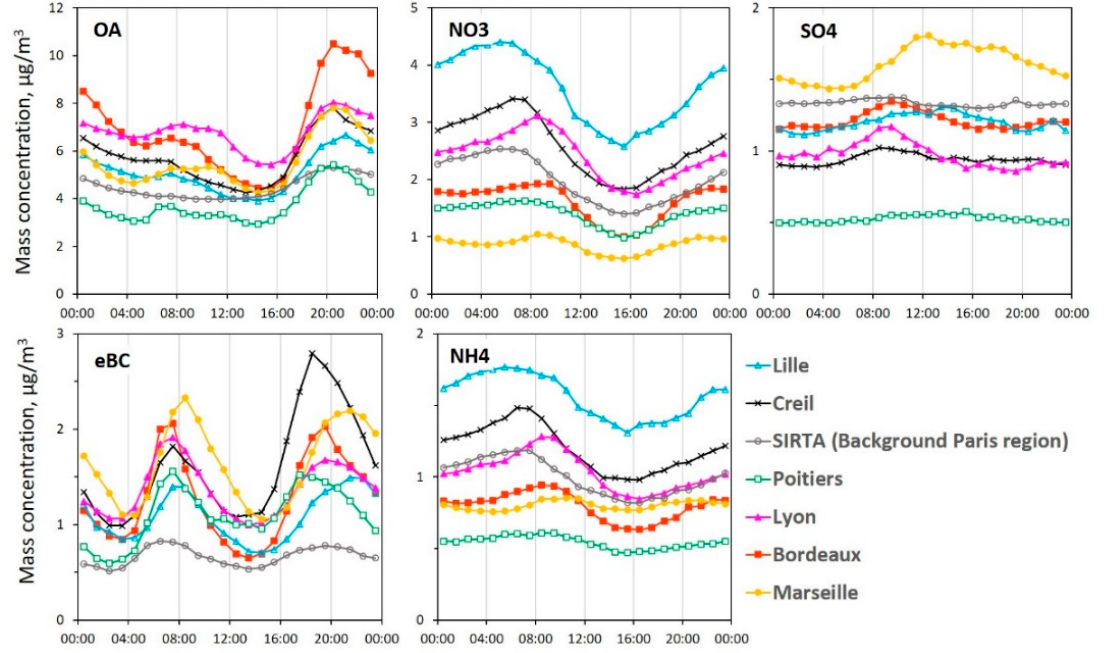
Figure 6. Mean diel variation of the main components of the fine aerosol mode as measured at seven sites of the CARA program in the years 2017–2018.